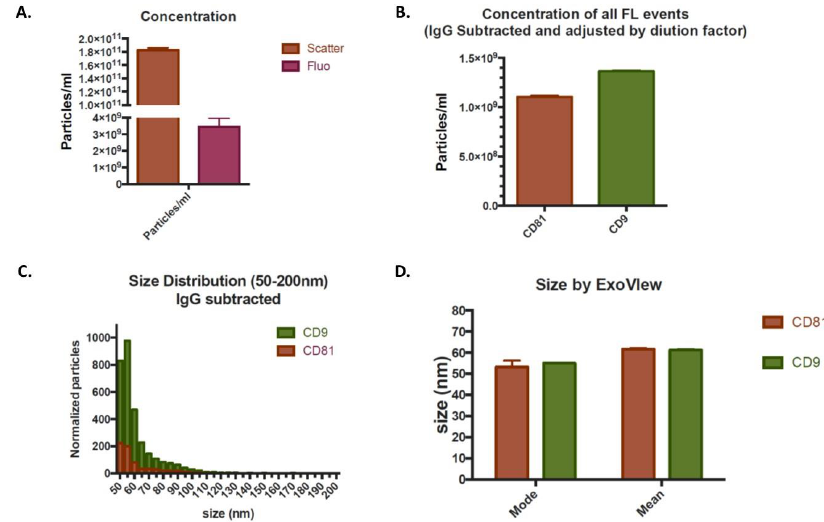
Figure 2. A representative nanoparticle tracking analysis showed the presence of 183 ± 3.45 billion particles/mL in the light scattering mode and 3.45 ± 0.51 billion particles in the fluorescent mode. Values are shown as mean ± standard error ( A ), and image for concentration of all fluorescent events showed presence of 1.1 billion/mL and 1.35 billion/mL CD81 and CD9 expressing particles, respectively ( B ). Representative histograms of the size distribution ( C ) and mean/mode values ( D ) of CD81- and CD9-expressing EVs measured by interferometry.